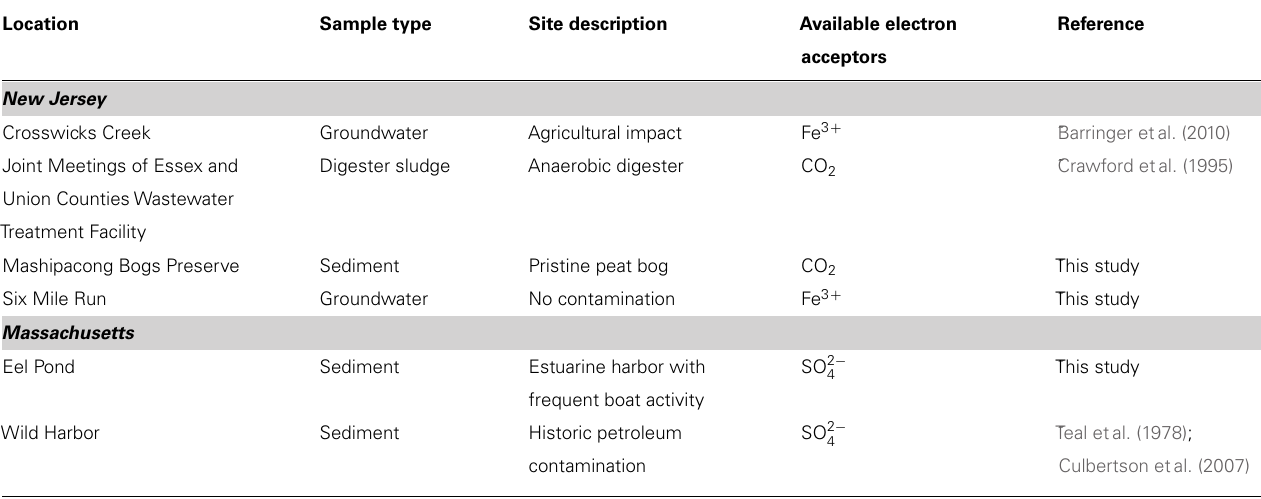
Table 1 | Sites that have tested positive for the bamA gene grouped by the states in which the sites are